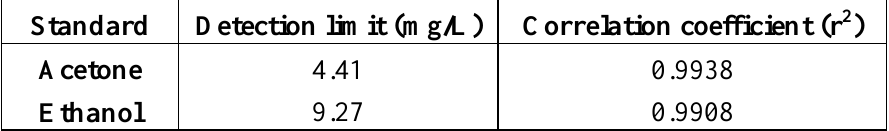
Figure 8. Ethanol calibration curve in the 10-60 mg/L concentration range